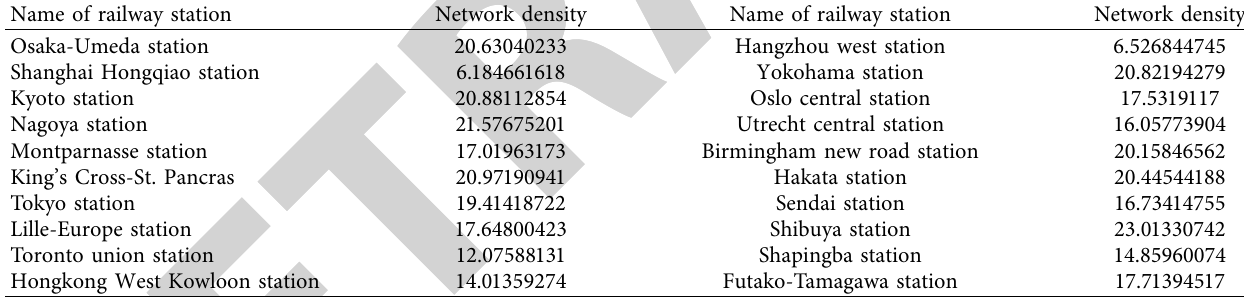
Table 2: Data of road network density obtained from the BaiduMap database. Name of railway